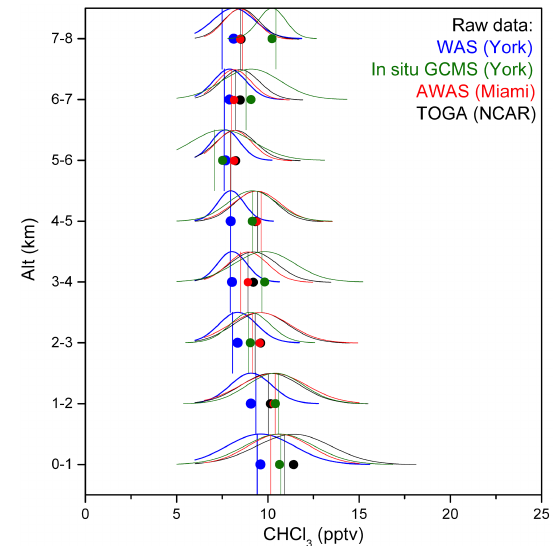
Figure 3. Comparison of unadjusted CHCl 3 mixing ratios measured by all four instruments, averaged into 1000m altitude bins. Circles and vertical lines are the means and medians of the binned data with the distribution represented by a normal distribution